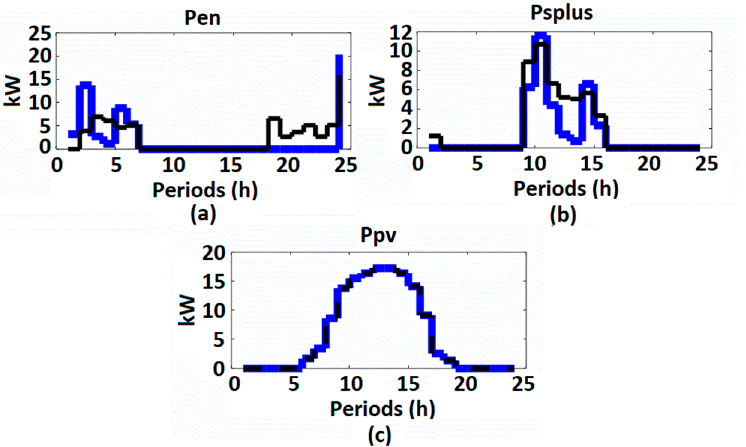
Figure 5. Variation during the day of the ( a ) power supplied by the energy company, ( b ) surplus power injected into the power grid, and ( c ) power produced by the shared PV plant.